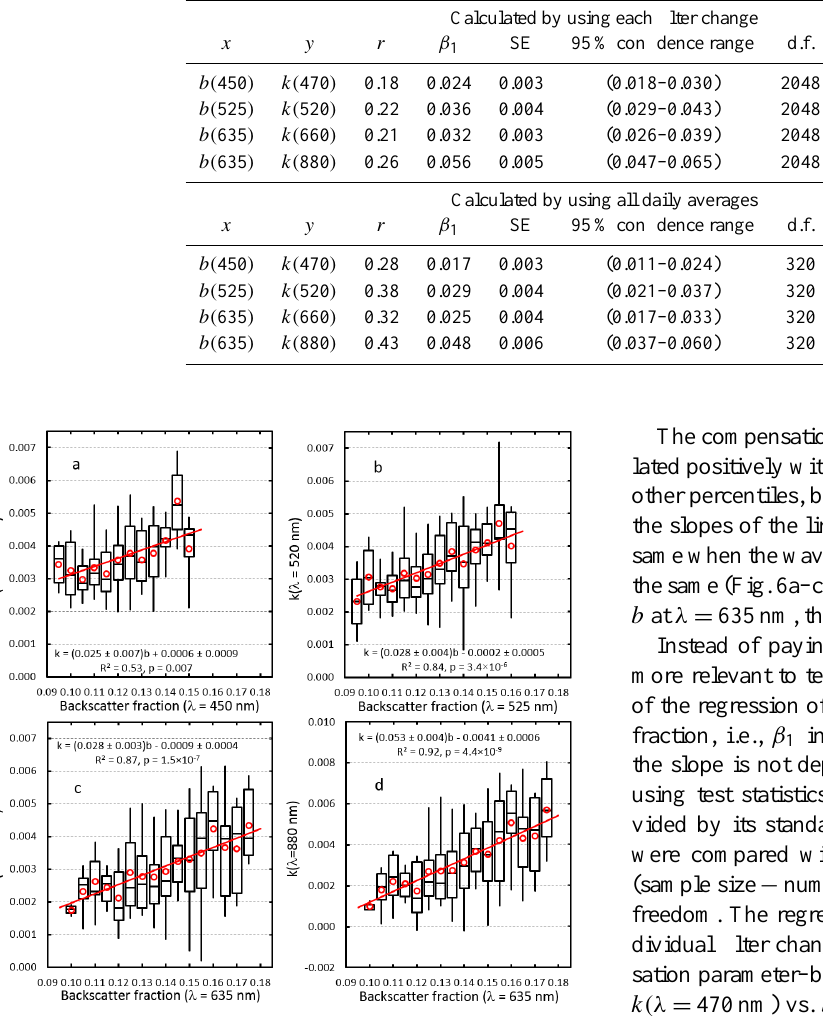
Figure 6. Daily averaged compensation parameters of (a) blue ( λ = 470nm), (b) green ( λ = 520nm), (c) red ( λ = 660nm), and (d) near-infrared ( λ = 880nm) light classified into 0.005 wide bins of the backscatter fraction at the nearest nephelometer wavelengths ( λ = 450, 525, and 635nm). The box plots present the 5th, 25th, 50th, 75th, and 95th percentiles and the circles the averages in each bin. The lines are linear fittings to the bin averages and the uncer- tainties of the slope and offset the standard errors obtained from the